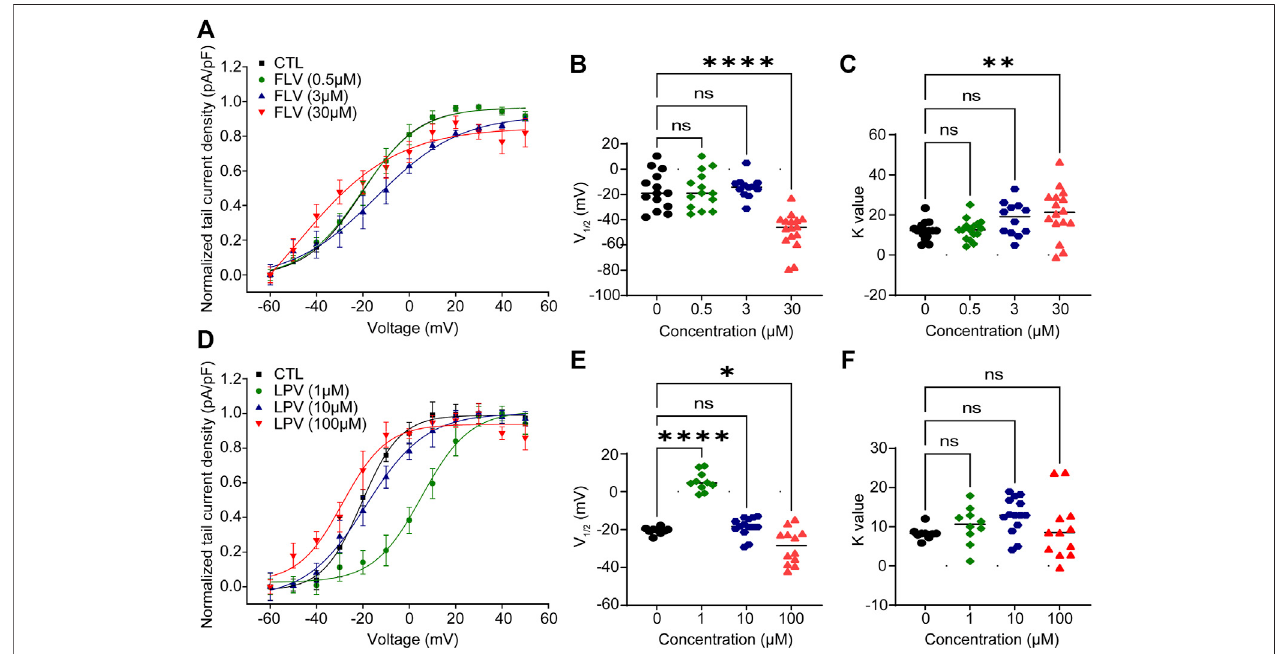
FIGURE 3 | FLV and LPV cause left-shifting of the voltage-dependent activation curve and dramatic slowing of activation. (A,D) Peak tail current amplitude is normalizedtotheirrespectivemaximalamplitudeandusingthecurrentdensity(pA/pF)ofeachcelltoformthe fi ttedpeaktailcurrentI – VcurvebytheBoltzmannfunction to obtain the voltage for half-maximal channel activation (V 1/2 ) and slope factors K value from the curve of control (CTL) or each inhibitory concentration. (B,C) Scatter plots of individual values showing V 1/2 and K values at 0 μ M (CTL) to30 μ M FLV ( n = 12 – 16). ** p < 0.01 and **** p < 0.0001 compared with CTL. (E,F) Scatter plots of individual values showing V 1/2 and K values at 0 μ M (CTL) to 100 μ M LPV ( n = 9 – 14). * p < 0.05 and **** p < 0.0001. ns, non-signi fi